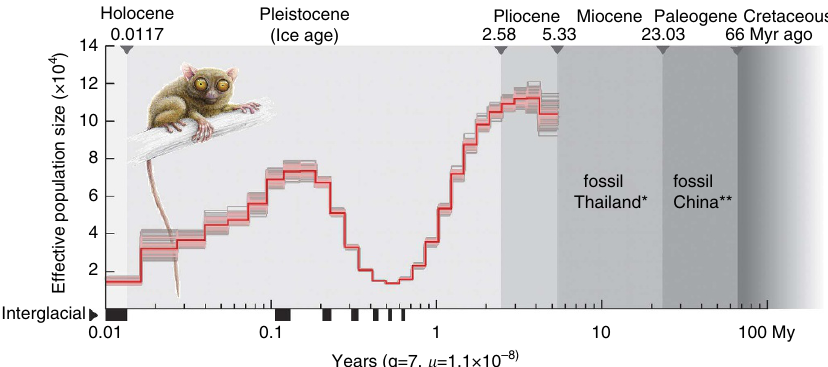
Figure 5 | Historical effective population sizes of T. syrichta. N e was derived by the pairwise sequential Markovian coalescent model (PSMC) 44 . The x axis gives a log scale of the time in years (adapted to the major glacial epochs), applying a genome mutation rate of m ¼ 1.1e (cid:3) 8 per site and generation time of 7 years 66 . The bold red line shows the effective population size through time. The thin pink and grey lines represent 100 rounds of bootstrapped sequences. The interglacial epochs are indicated with black bars on the x axis. *A fossil tarsier from the middle Miocene of Thailand 47 ; **a fossil tarsier from the Eocene of China 46 . The drawing of tarsier has been reproduced from Hartig et al. 14 with